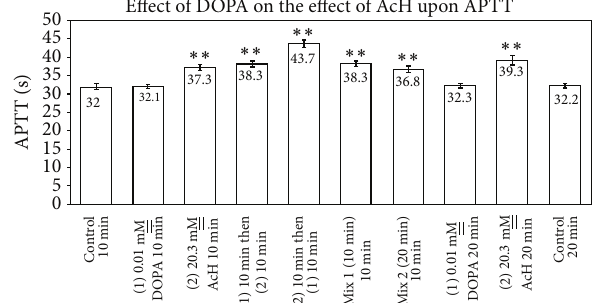
Figure 9: Effect of DOPA and acetaldehyde upon APTT ( 𝑛 = 7 ; 𝑃 ≤ 0.05 relative to the controls). APTT upon preincubation with plasma for 10 min ( 𝑃 = 0.0001 ) as well as 20 min ( 𝑃 = 0.0002 ), premixtures of acetaldehyde with DOPA for 10 min or 20 min do not differ statistically from acetaldehyde alone in their APTT